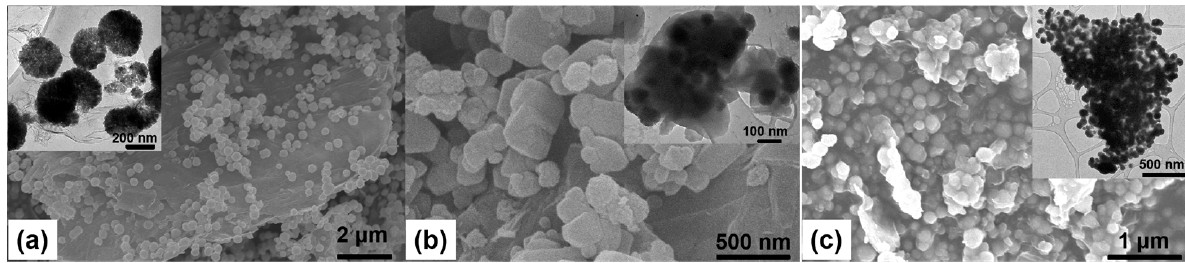
Figure 1. Morphology of ( a ) MRGO, ( b ) MRGO@ZIF-7, and ( c ) MRGO@ZIF7-MIP.